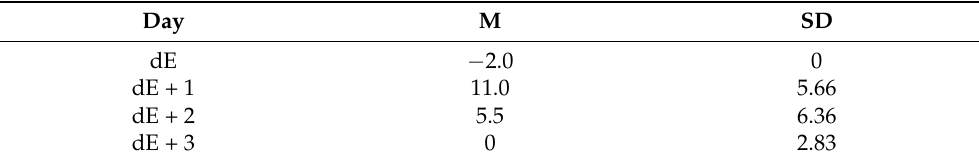
Table 5. Means and standard deviations of intolerance reactions to corn of Group 1 ( n = 2).